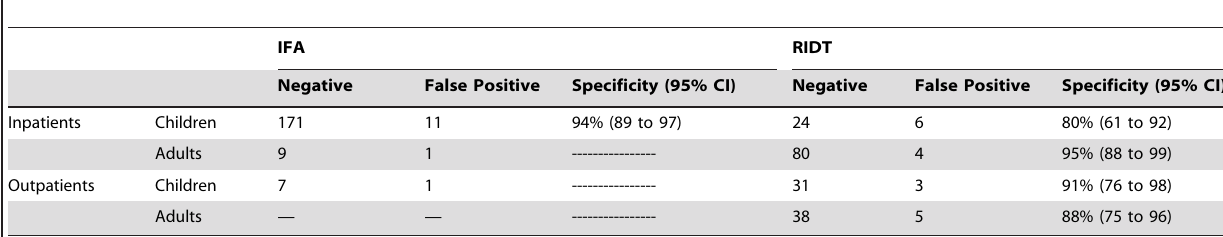
Table 2. Comparison of Specificity for RIDT and IFA Tests by Severity and Age using PCR as the Gold